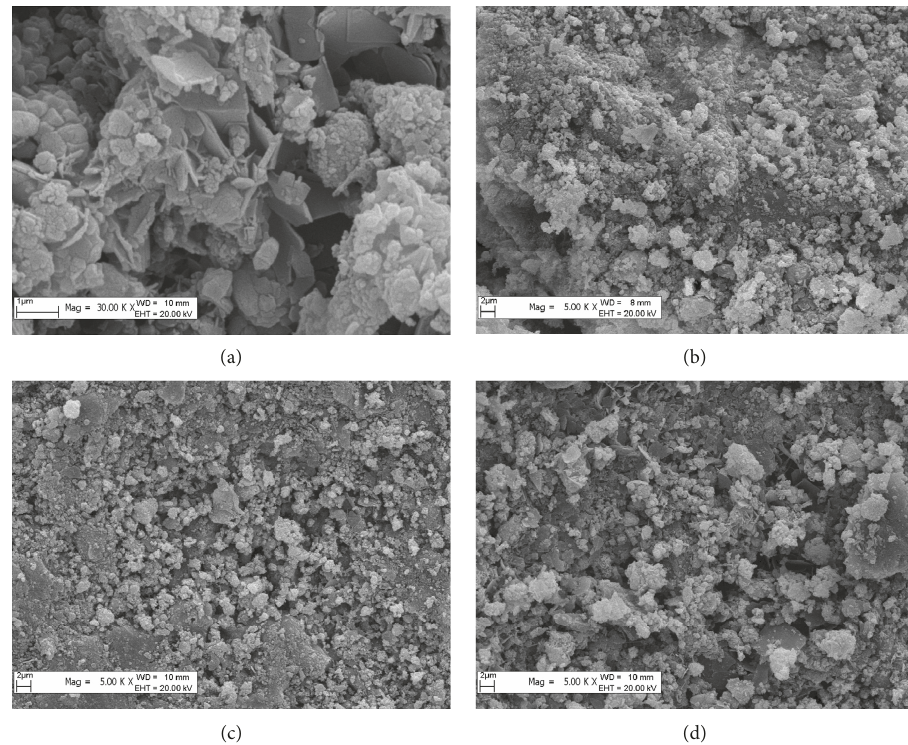
Figure 7: Microstructure of NCC-0-0, RCC-30-10, RCC-30-10, and RCC-30-10 in the experimental group. Magnification of the mi- crostructure of (a) NCC-0-0, (b) NCC-0-10, (c) RCC-30-0, and (d)